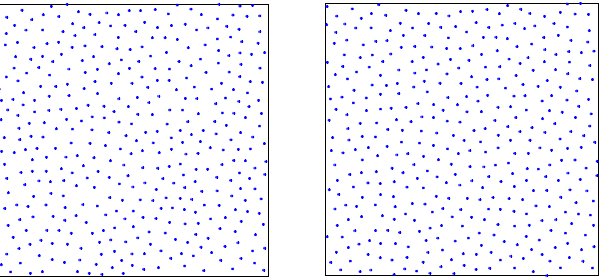
FIG. 2. A disordered nonhyperuniform configuration (left panel) and a disordered hyperuniform configuration (right panel). We arrive at the configuration on the right by very small collective displacements of the particles on the left via the methods described in Ref. [12]. (Each particle on average moves a root-mean-square distance that is about an order of magnitude smaller than the mean-nearest-neighbor distance as measured by the configuration proximity metric [53].) These two examples show that it can be very difficult to detect hyperuniformity by eye, and yet their large-scale density fluctuations are dramatically different ( “ hidden order ”